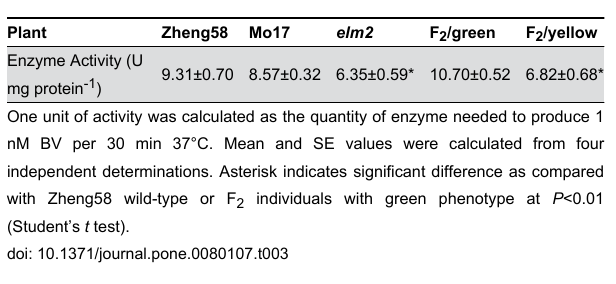
Figure 5. Map-based cloning of elm2 . The F was generated by crossing elm2 to the wild-type line Zheng58. 8,350 recessive individuals with a yellow-green phenotype were selected for mapping. The candidate region was finally located to a 920 kb region on chromosome 9, which was near the centromere.